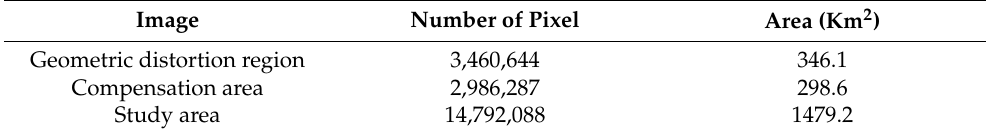
Figure 16. Enlarged classification results of regions A and B based on different feature combinations: ( a ) optical image of area A; ( b ) classification result of Uncompensated_DOPC_DpRVI area A; ( c ) classification result of area A in the result diagram of Compensated_DOPC; ( d ) classification result of area A in the result diagram of Compensated_DOPC_DpRVI; ( e ) optical image of area B; ( f ) classification result of area B in the result diagram of Uncompensated_DOPC_DpRVI; ( g ) classification result of area B in the result diagram of Compensated_DOPC; ( h ) classification result of area B in the result diagram of Compensated_DOPC_DpRVI. Table 4. Compensation situation.